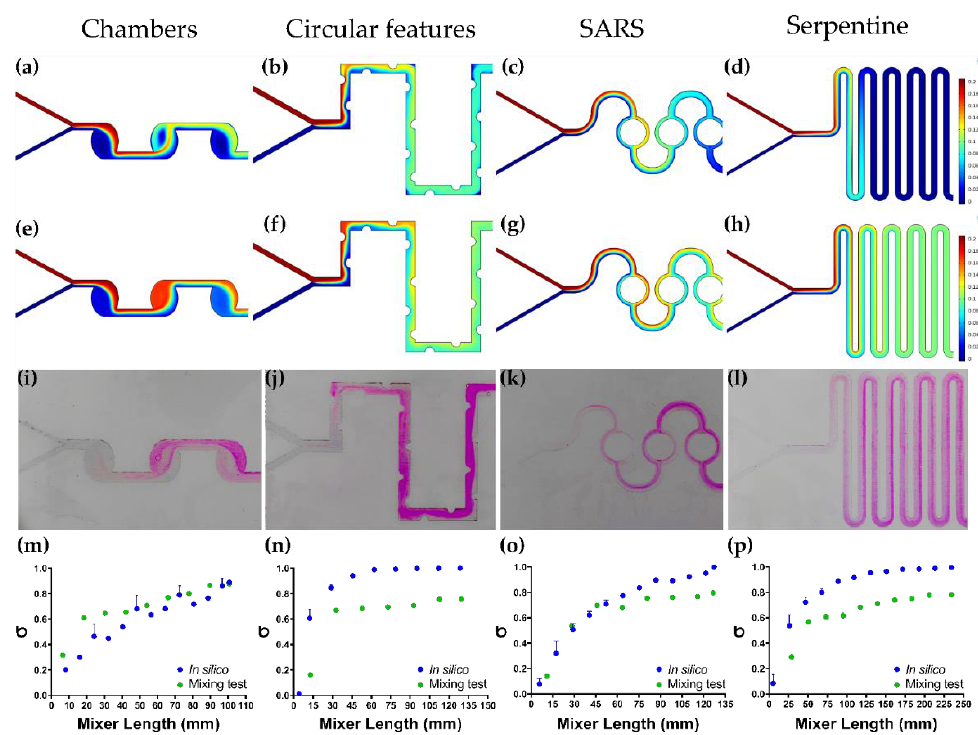
Figure 5. Dispersed phase volume fraction simulations and colorimetric mixing efficiency results in silico and in vitro. ( a ) Chambers, ( b ) Serpentine with circular features, ( c ) SARS, and ( d ) Serpentine mixing profile ( φ d ) at 2 s. ( e ) Chambers, ( f ) Serpentine with circular features, ( g ) SARS, and ( h ) Serpentine mixing profile ( φ d ) at 15 s. ( i ) Chambers, ( j ) Serpentine with circular features, ( k ) SARS, and ( l ) Serpentine in vitro colorimetric mixing profile. ( m ) Chambers, ( n ) Serpentine with circular features, ( o ) SARS, and ( p ) Serpentine in silico and in vitro mixing efficiency along micromixer length. Table 1. Micromixing parameters. Mixing time (MT), mean residence time (MRT), trajectory length (TL) (Characteristic length), pressure drop ( ∆ P), mixing efficiency (ME), and ratio of mixing index to pressure drop (ME/ ∆ P) calculated.